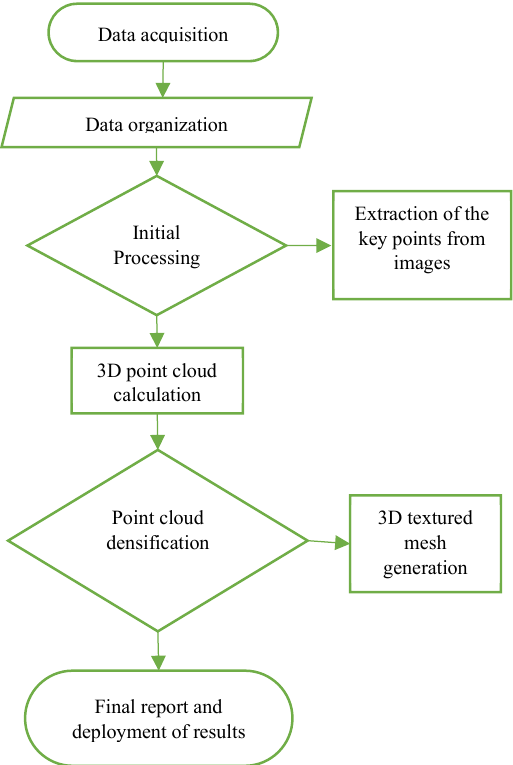
Figure 2: Workflow performed in Pix4d Rebuild software